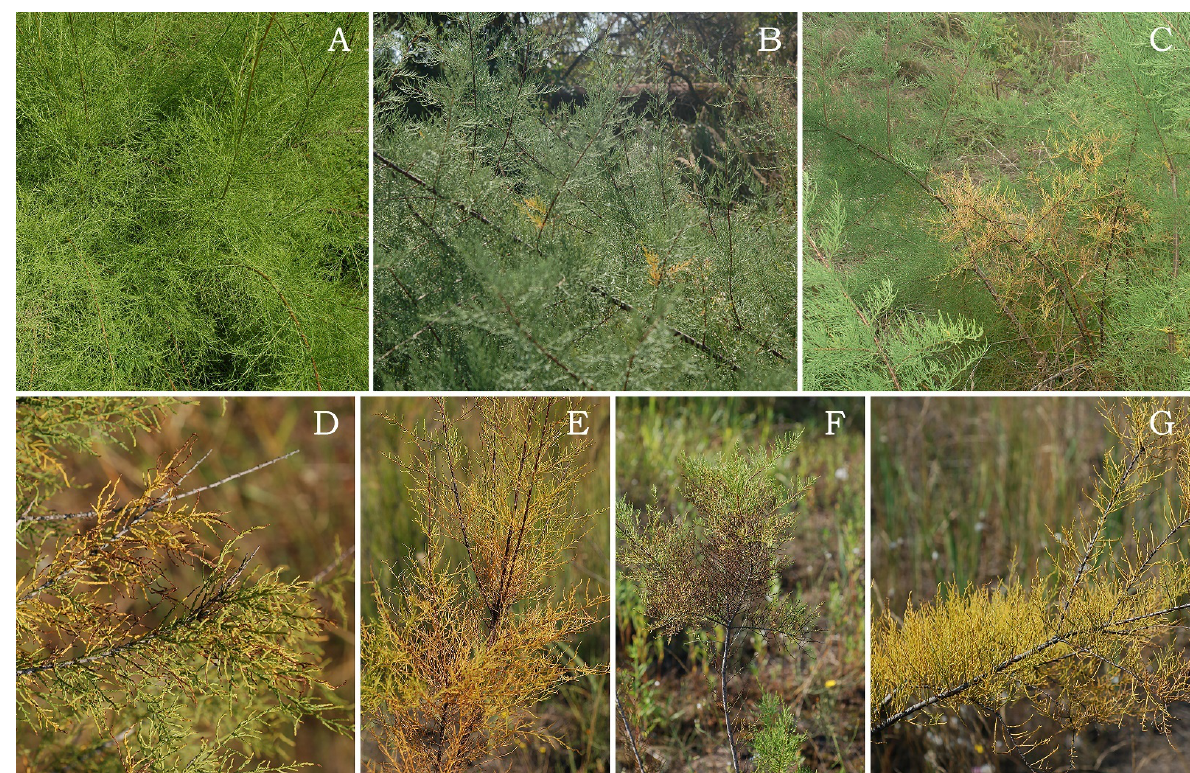
Figure 5. Morphological changes on the leaves of T. tetrandra on soil ( A ) and fly ash at L1 ( B , C ) and L2 ( D – G ). Table 5. Spearman’s correlations between physiological and biochemical parameters and heavy metal(loid) concentrations in T. tetrandra leaves